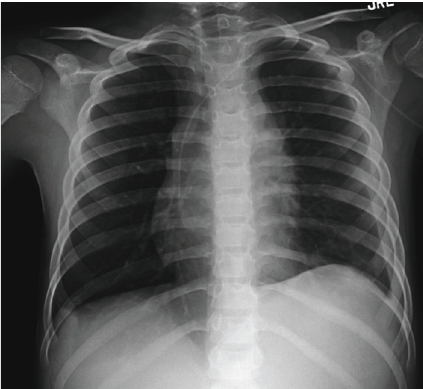
Figure 5: Chest radiograph before discharge demonstrating re- solved pulmonary edema.